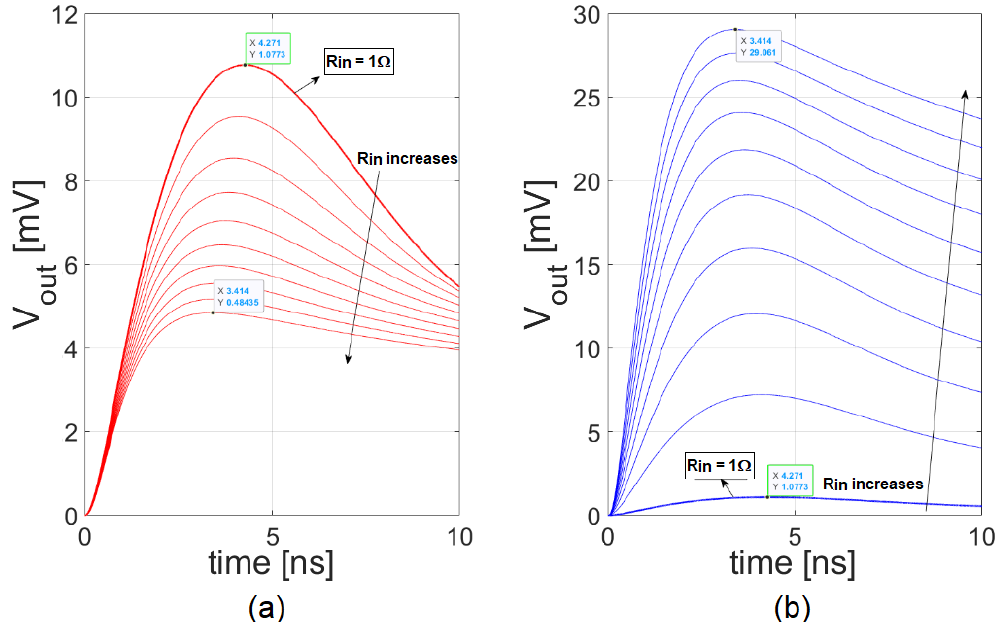
Figure 10. The current-mode ( a ) and voltage-mode ( b ) responses as functions of the input resistance when L par = 70 nH, C in = 0.5 pF, and BW = 0.5 GHz, obtained using the complete model.